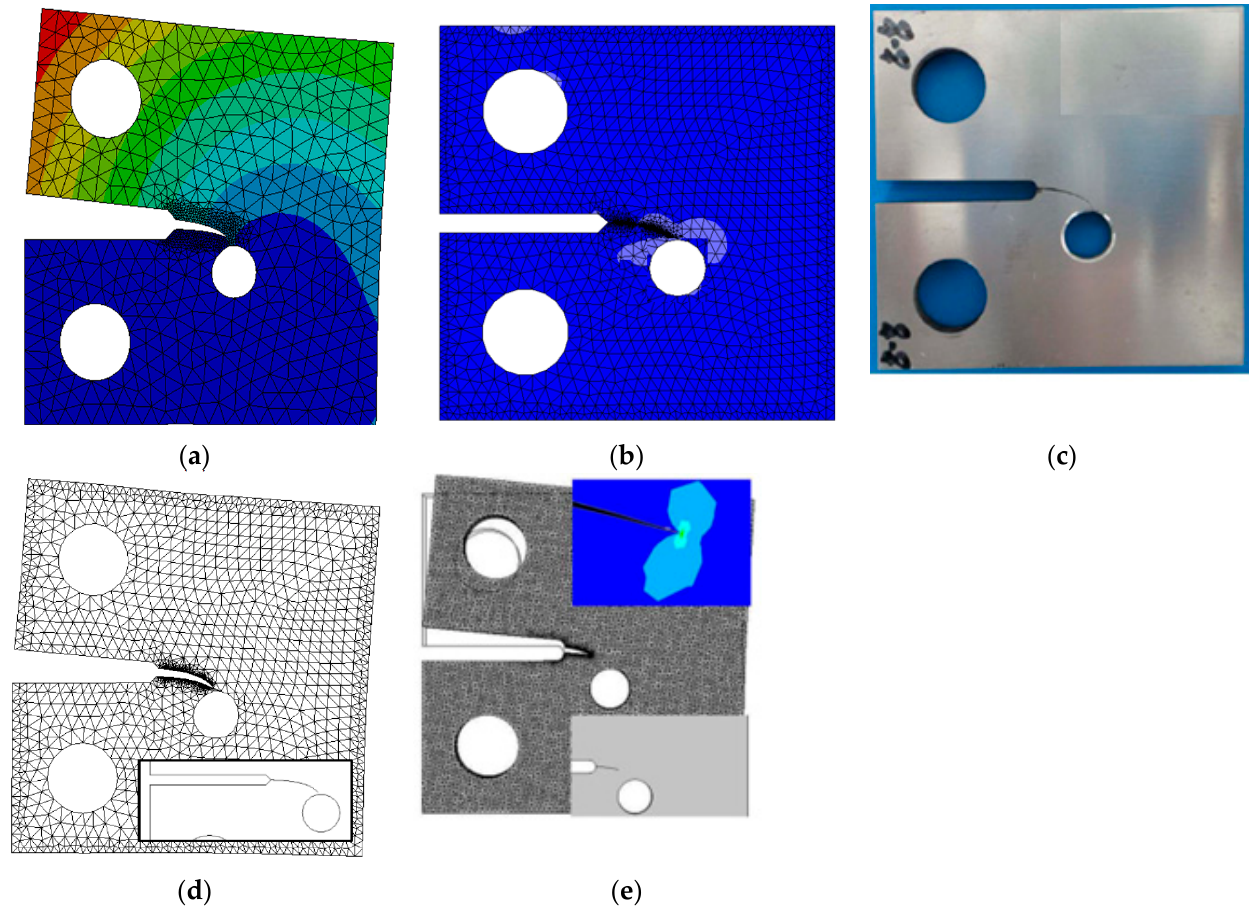
Figure 8. Predicted crack growth path for G3 specimen ( a ) ANSYS Workbench, ( b ) FRANC2D/L and ( c ) Experimental [32], ( d ) numerical [33], ( e ) FRANC3D [32].